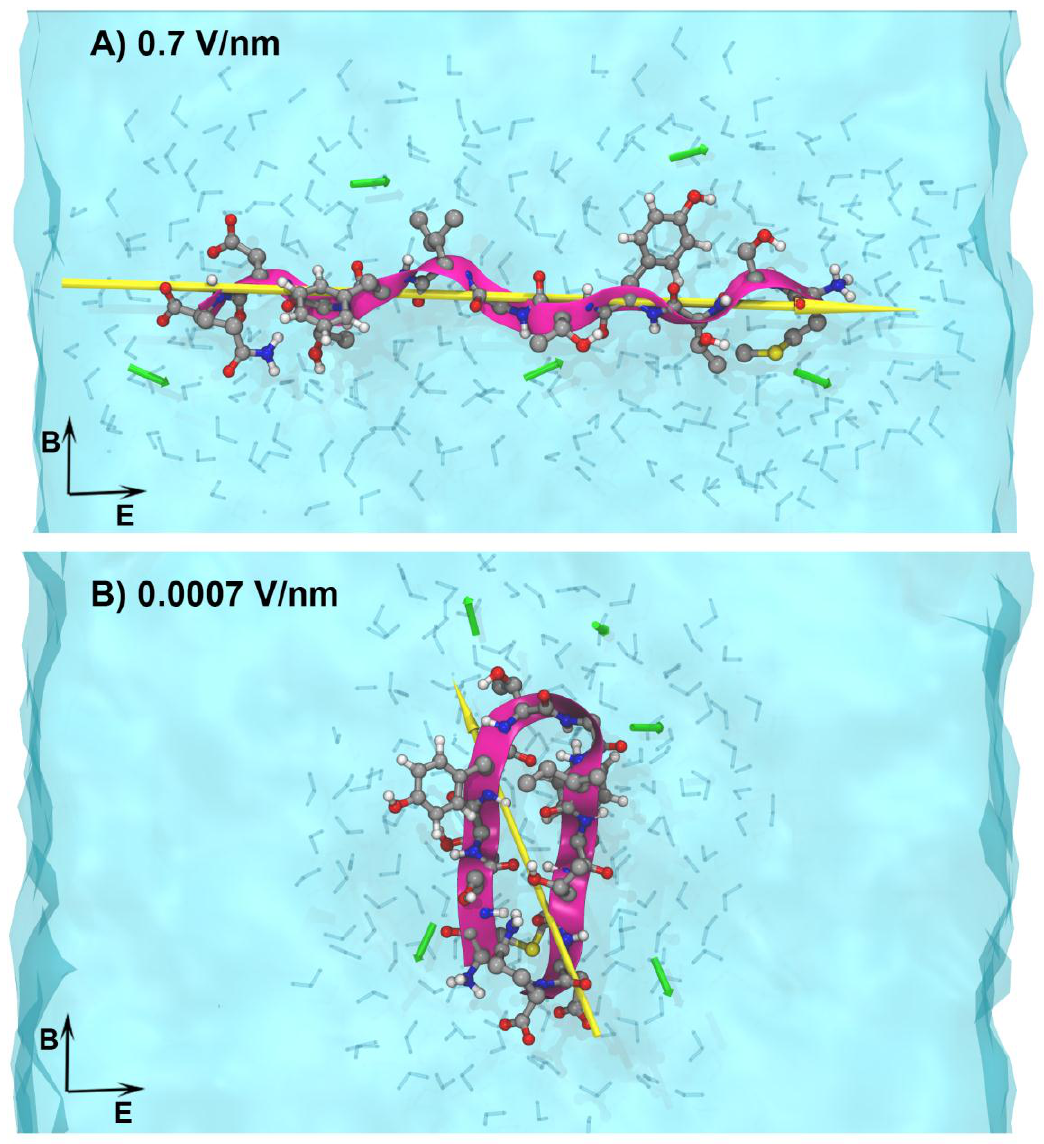
Figure 2. All-atom computer model of an amyloid peptide in solution under the influence of varying strength electromagnetic fields (EMF) (from [47]), ( A ) exemplifies the amyloidogenic ApoC-II peptide adopting an elongated conformation under the fields higher than 0.04 V/nm due to the peptide dipole alignment along the electric field direction; ( B ) illustrates the peptide conformation being native-like under the fields less than 0.04 V/nm in strength. For detailed systematic analysis of the EMF field strength effects on the conformational dynamics of this peptide refer to [47]. The peptide conformation is shown as a ribbon (purple) and atomic structure in CPK representation. Water molecules near the peptide are shown explicitly in grey CPK representation and the overall solution is coloured blue. Yellow arrows represent the peptide dipole moment and black arrows represent the direction of the applied electric and magnetic field respectively.